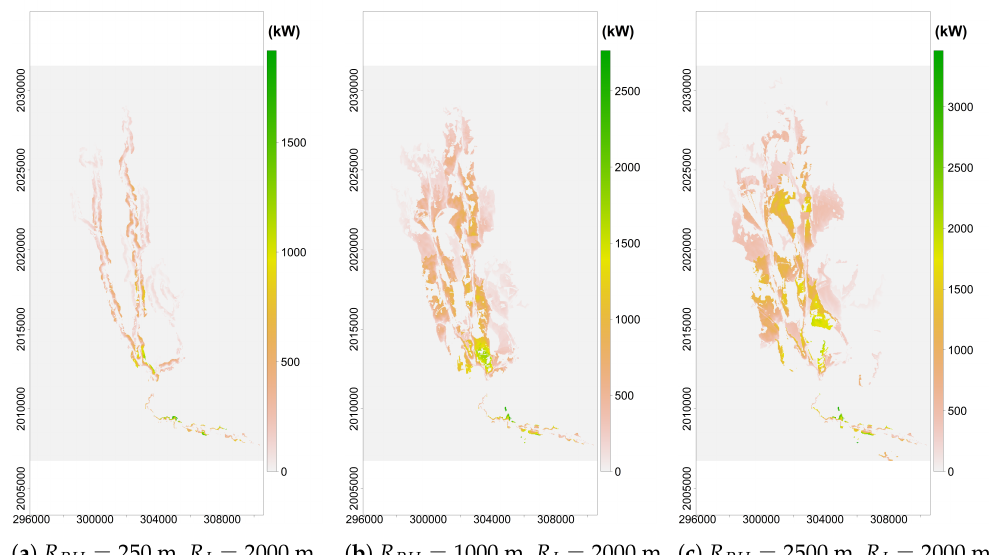
Figure 8. Hydropower maps for fixed maximum headrace’s length R I = 2000 m.